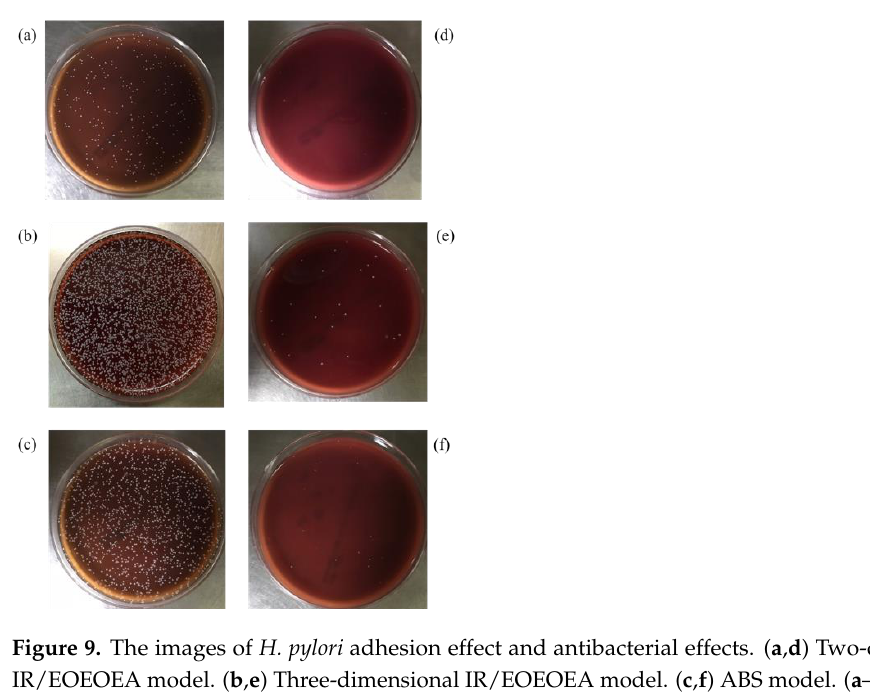
Figure 8. The anti-bacterial effect of 2D and 3D model in different time under a shaking of 50 rpm in the pH 2 environment. Two-dimensional IR/EOEOEA is a photo-cured flat surface sample. Three- dimensional IR/EOEOEA is a photo-cured sample with gastric rugae. ABS is a flat surface sample.